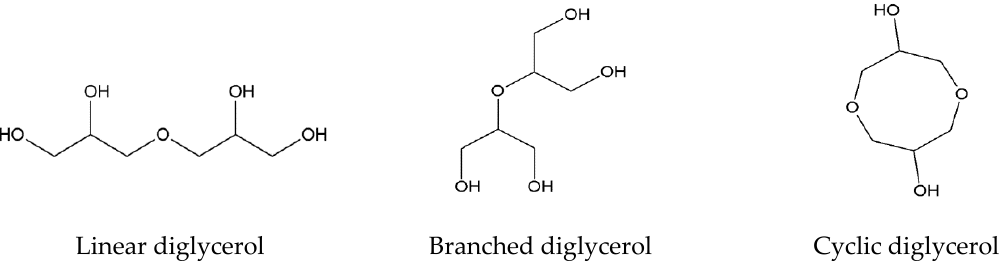
Figure 1. Examples of diglycerol structures, which can be formed in the glycerol etherification